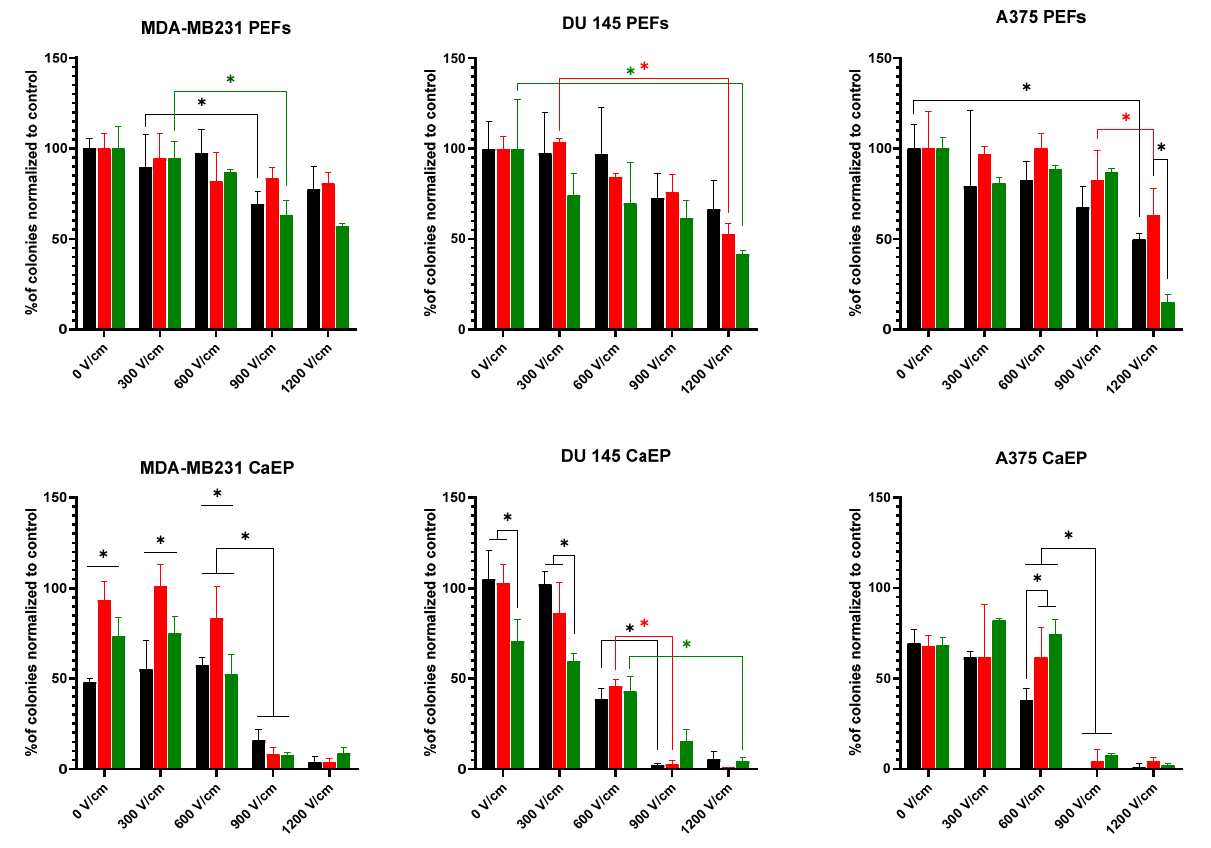
Figure 7. Colony-forming properties of the MDA-MB231, DU 145, and A375 cells after preincubation with 50 nM atorvastatin and electroporated with and without 5 mM calcium ions. To show the long- and short-term effect of the statin on the efficacy of PEF treatment, we analyzed three types of cells: Black line: cells without atorvastatin; red line: cells preincubated with 50 nM atorvastatin for 48 h before PEF treatment (long-term effects); green line: the cells which were treated with 50 nM atorvastatin directly in the electroporation buffer (short-term effects—without 48 h preincubation time). Data presented as mean ± SD, ANOVA analysis * p <